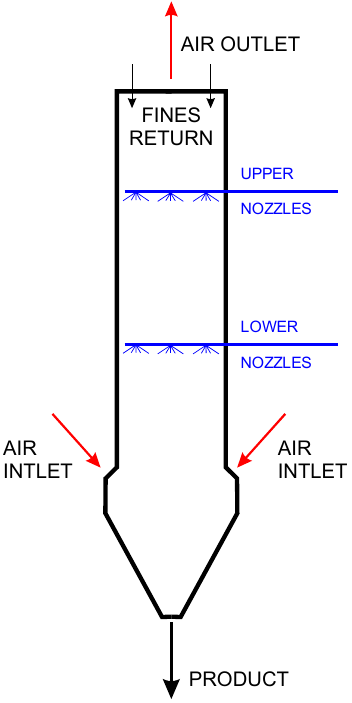
Figure 13. Schematic of industrial spray dryer for detergents with nozzle locations. The lack of swirl due to the geometry of the tower and construction of the air inlet ring resulted in high instability of air flow in the tower. A robust agglomeration process was observed in the tower, as the initial average particle size increased from 285 μ m to the final 770 μ m in the product. The initial velocity of particles was 50 m/s. Cumulative initial and final and percentage undersizing PSD in the industrial tower are presented in Figure 14.